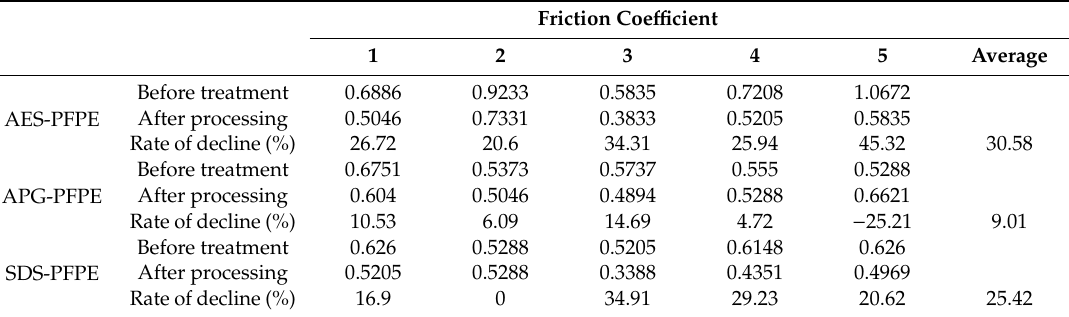
Table 3. Friction coe ffi cient of cotton after processing by